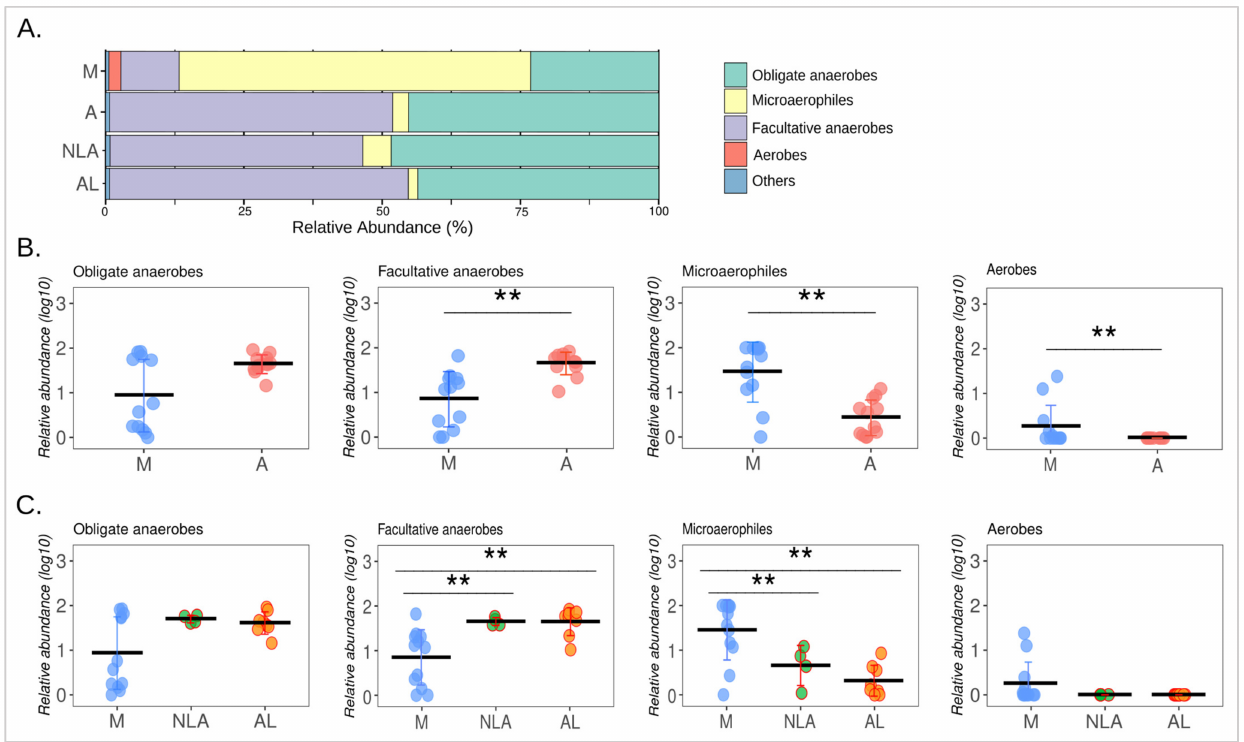
Figure 6. Microbial respiration of microbiota. ( A ) Relative abundances (%) of species classified by respiration type. ( B ) For M and A comparations, Wilcoxon rank sum test was used. ( C ) For M, NLA and AL, Kruskal–Wallis and Bonferroni’s post hoc were performed. ( B , C ) graphs depict relative abundances (Log10) where each data point represents a sample, and the horizontal lines represent the means. Error bars depict standard deviations. Statistical significance: ** p < 0.005. M: control